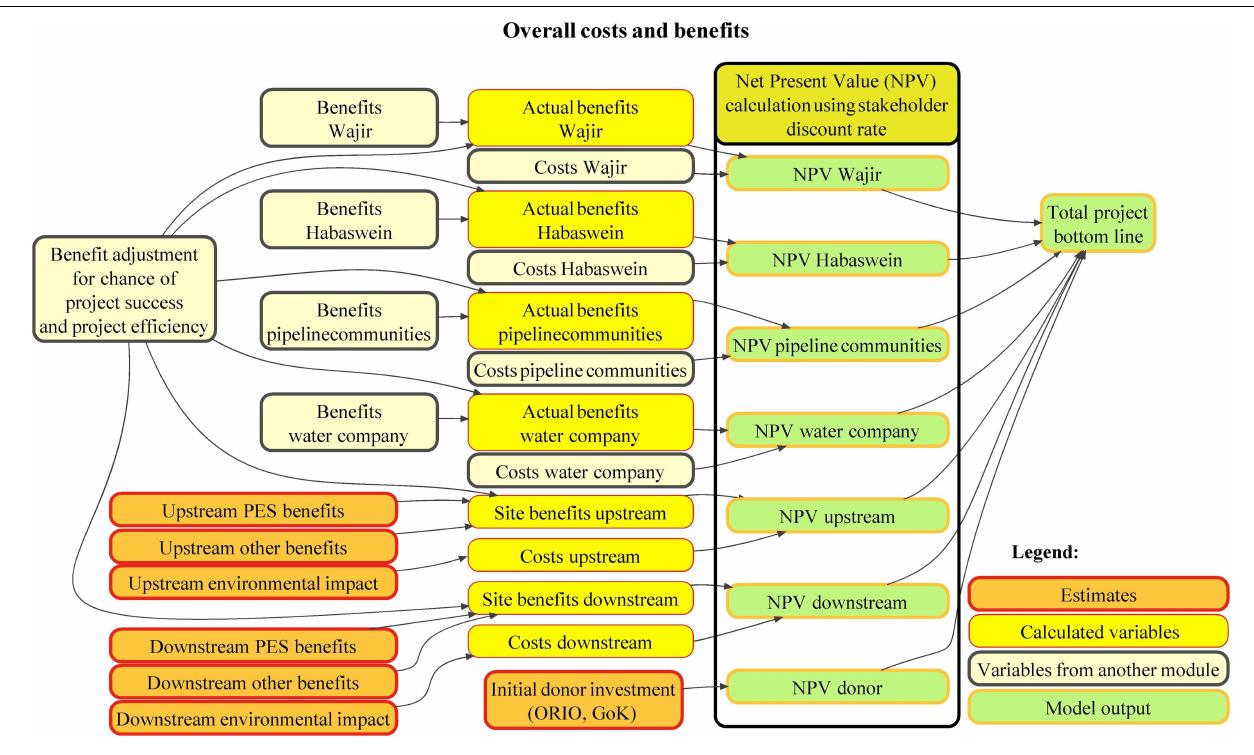
FIGURE 3 | Overall structure of the decision